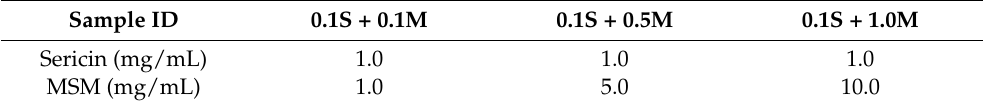
Table 2. Sericin and MSM blends